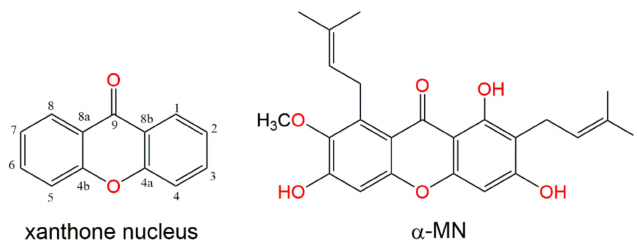
Figure 1. Xanthone nucleus and the α -MN